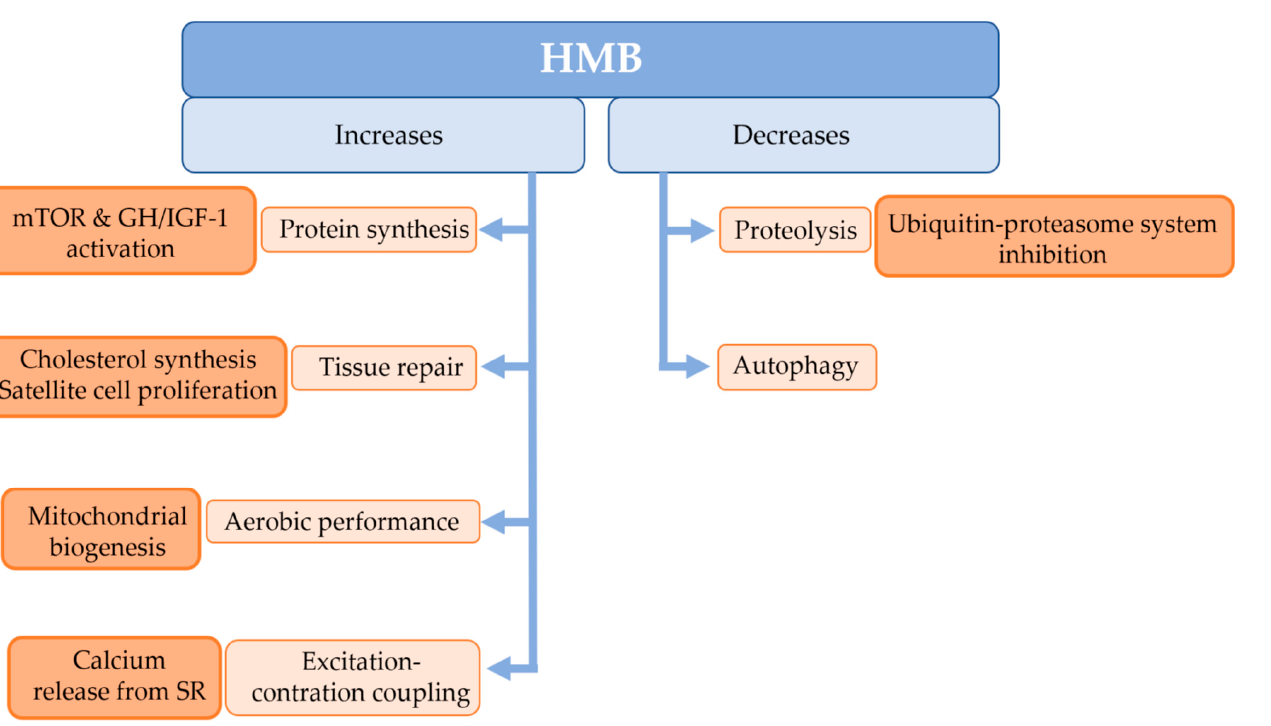
Figure 3. Suggested mechanisms for the effects of HMB on skeletal muscle. HMB: β -hydroxy- β - methylbutyrate, mTOR: mammalian target of rapamycin. GH/IGF-1: growth hormone/insulin-like growth factor 1, SR: sarcoplasmic reticulum.